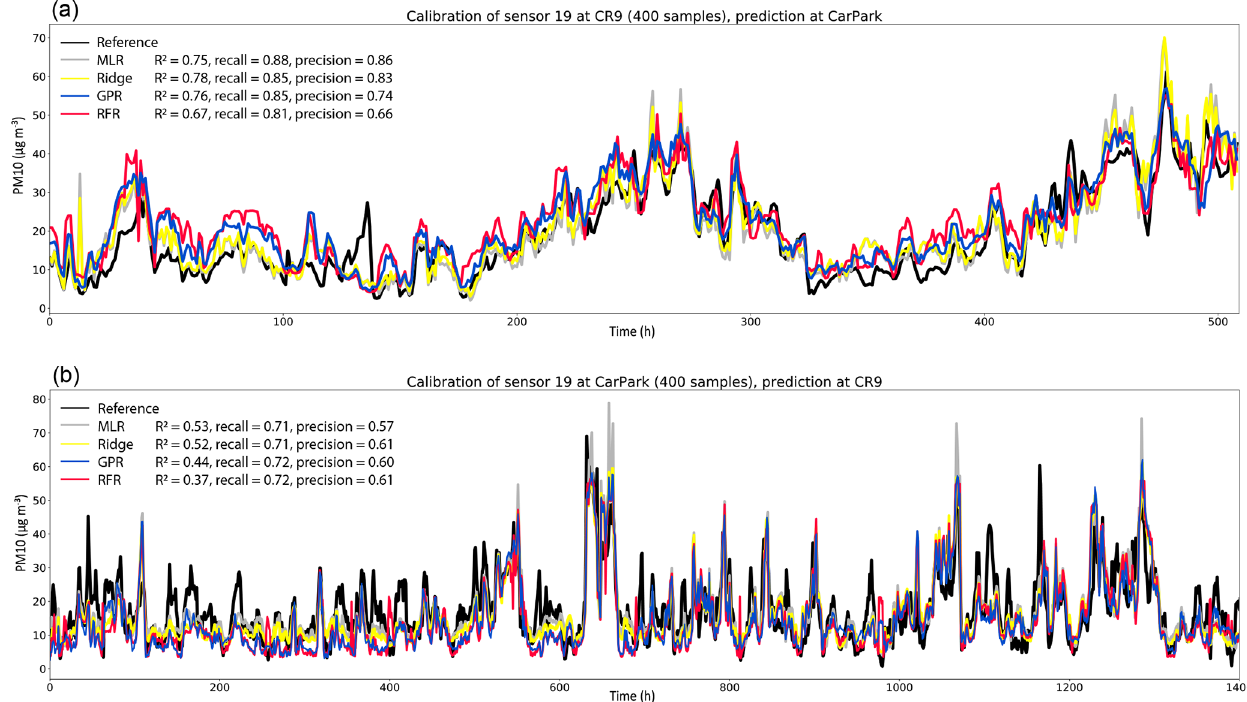
Figure 7. Tests of PM 10 sensor site transfers using calibration models trained on 400h of data. (a) Predictions for the four regression models (as labelled) and reference measurements at location CarPark, using models trained at CR9, and (b) at location CR9, using models trained on data measured at CarPark. The inset values provide the R 2 scores for each method relative to the reference as well as the corresponding recall and precision for the detection of the strongest pollution events, which are typically of particular interest in real-life situations (here defined as events when two values within the last 3h exceeded a threshold of 35µgm − 3 ). For compactness, we only show data for times at which both reference and low-cost sensor data were available, and we label these hours as a consecutive